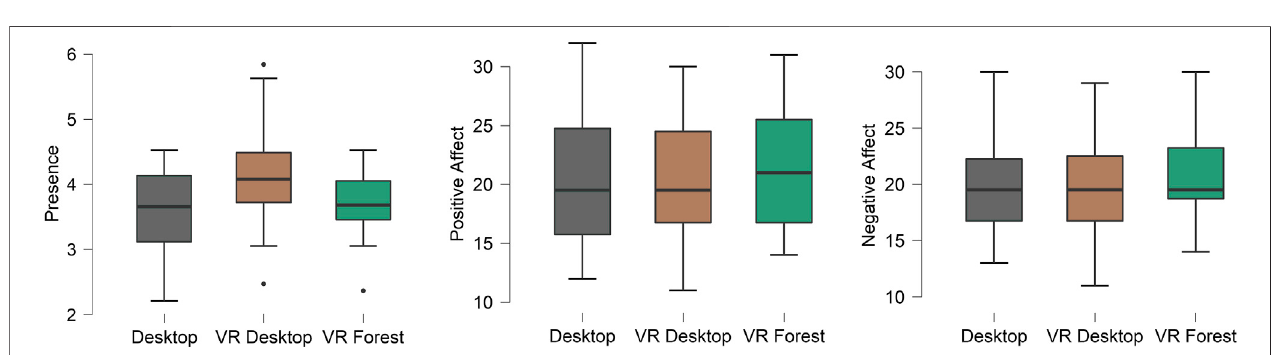
FIGURE 10 | Tukey-style box plots for the ratings of presence, positive affect, and negative affect. The median (line within the box), fi rst and third quartiles (box), non-outlier range (whiskers), and outliers (dot) are shown.